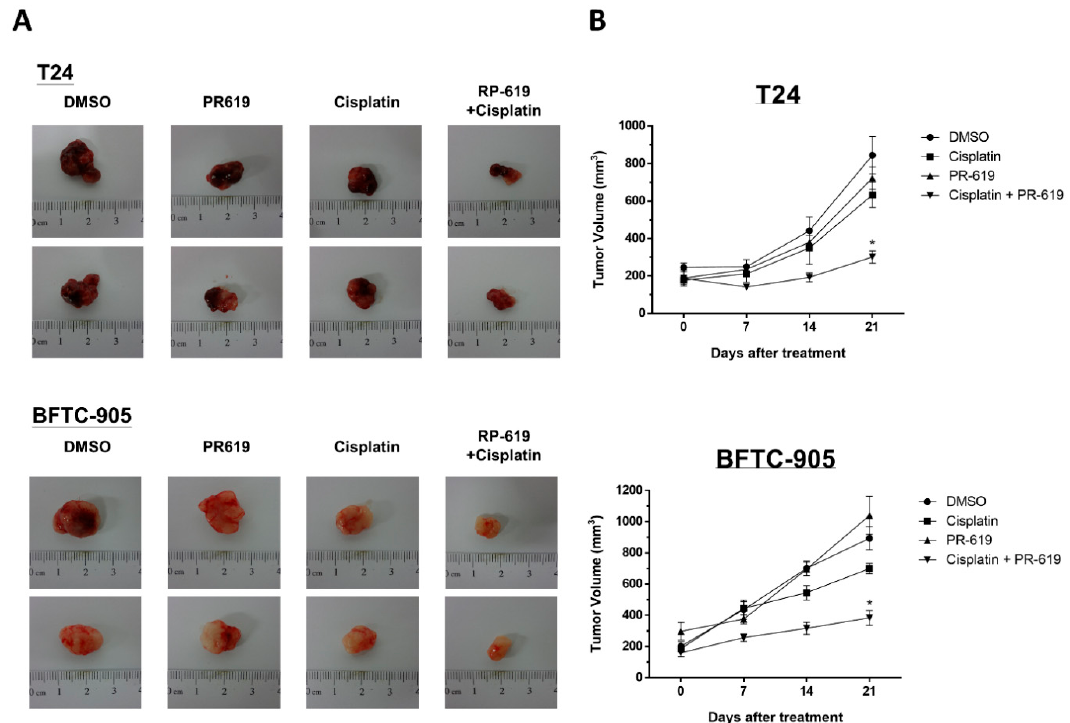
Figure 6. PR-619 enhanced the antitumor e ff ect of cisplatin on a UC xenograft mouse model. Nude mice bearing T24 or BFTC-905 UC tumor xenografts over the bilateral flank area were treated with DMSO (non-treated control, n = 5), cisplatin ( n = 5), PR-619 ( n = 5), or a combination of cisplatin and PR-619 ( n = 5) for three weeks. ( A ) Tumor images representing excised tumors from each group. ( B ) Tumor volume for each group during the three-week treatment. The data are presented as means ± standard error of the mean.